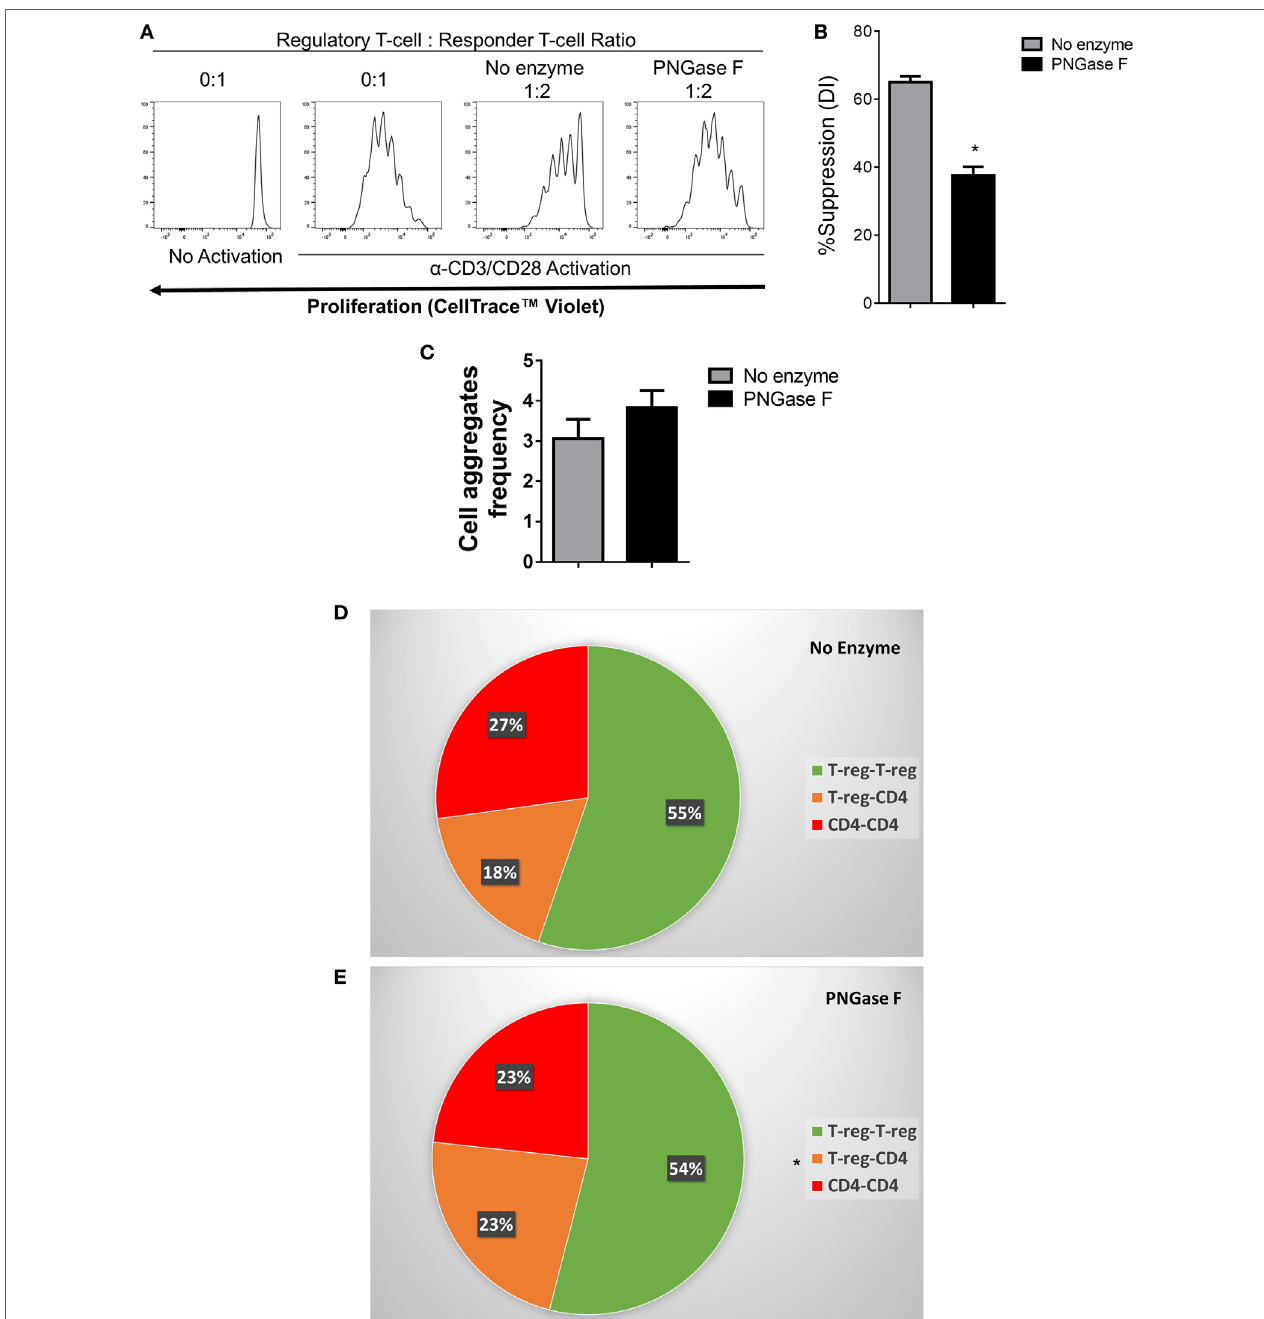
FigUre 10 | Flow cytometric analysis of the suppression of CD4 + responder T-cell proliferation and immune cell interactions established by PNGase F-treated Treg in the absence of antigen presenting cells. (a–e) Fluorescence-activated cell sorting (FACS)-purified mouse CD4 + Tconv were cultured alone (0:1) or cocultured in the presence of no enzyme or PNGase F-treated Treg at Treg: responder T-cell ratios of 0:1 and 1:2 for 4 days (a,B) or 8 h (c–e) with anti-CD3/CD28 Dynabeads ® stimulation. (a) Proliferation of CellTrace ™ Violet-labeled CD4 + Tconv incubated under different conditions and analyzed by flow cytometry. (B) Graph of the suppressive potency of no enzyme and PNGase F-treated Treg on CD4 + T-cell responders. Suppressive function was quantified based on responder T-cell division index (DI) and presented as the calculated percent suppression [%Suppression (DI)]. For evaluation of immune cell interactions in 8 h cocultures, FACS-purified cells were fluorescently labeled as follows: Treg with CellTrace ™ CFSE and CD4 + Tconv with CellTrace ™ Far Red DDAO-SE. (c–e) Flow cytometric quantification of the interactions present in the cocultures at 8 h presented as (c) a graph of the overall frequency of multi-cell aggregates and (D,e) pie charts showing the calculated frequencies of the different types of multi-cell aggregates present in the cocultures with (D) no enzyme and (e) PNGase F-treated Treg. Data represent mean ± SD ( n = 3 technical replicates). Statistical analysis was performed by permutation test with an unpaired design (* p value ≤